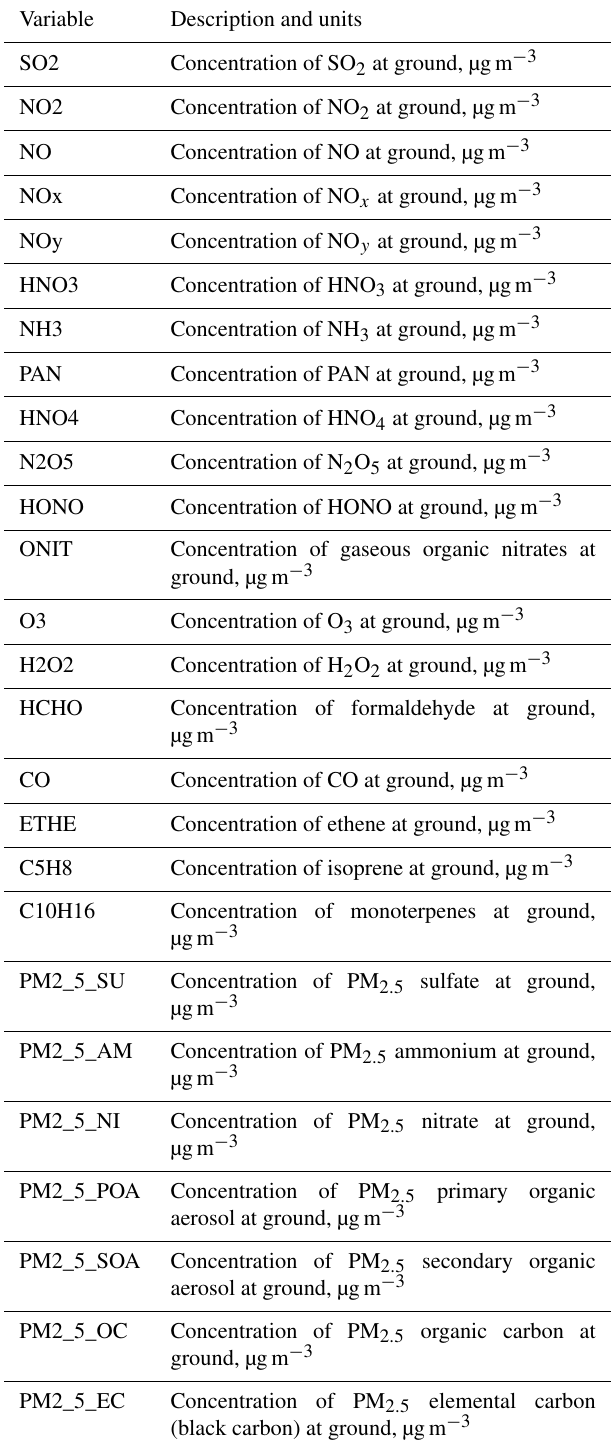
Table A2. AQMEII4 – gas and particle concentrations and emis- sions